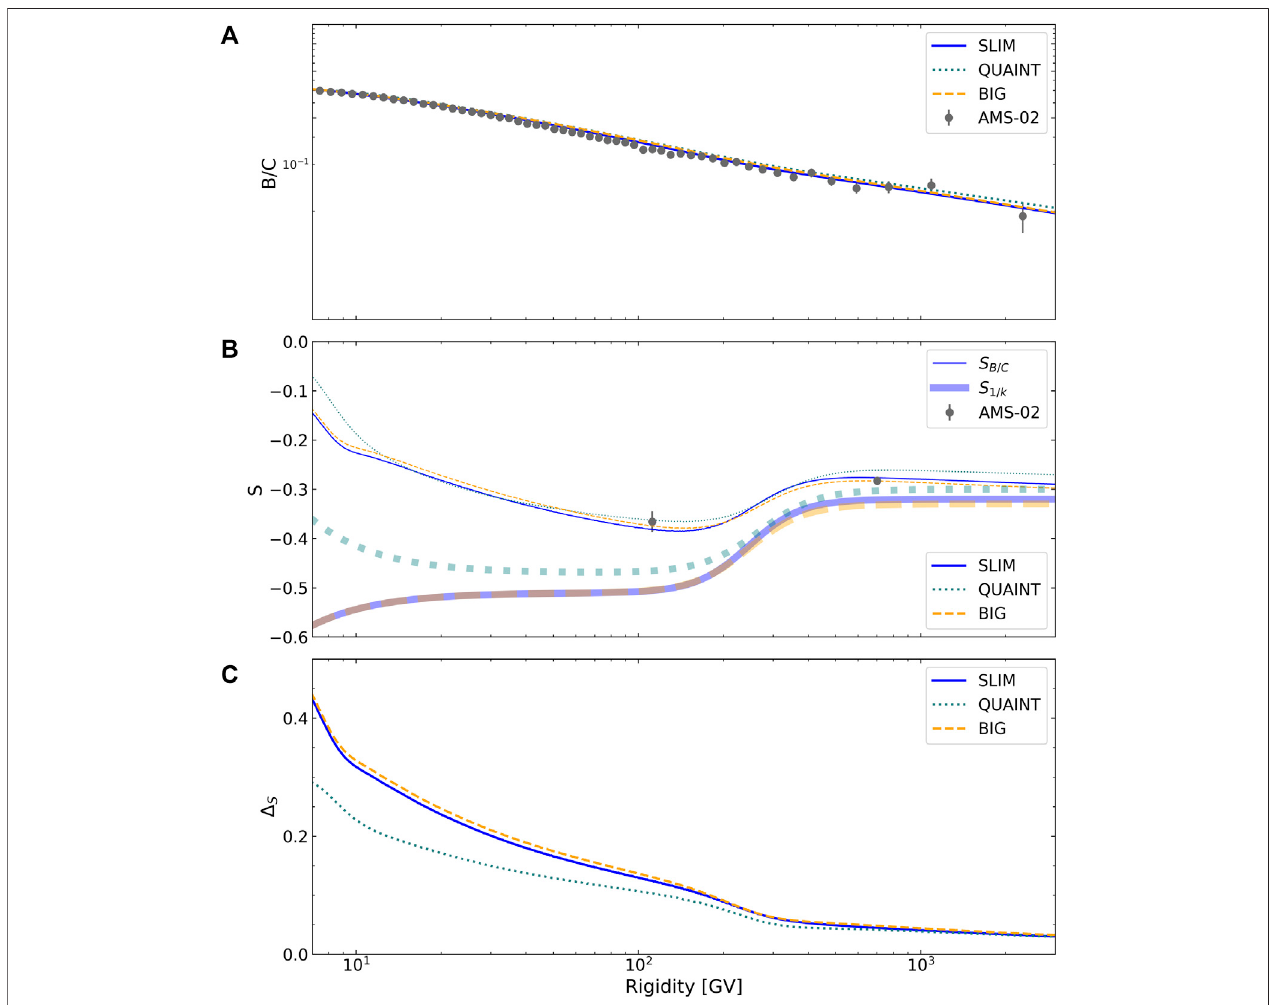
FIGURE 1 | Shown as a function of rigidity and for the three con fi gurations SLIM (blue solid lines), BIG (orange dashed lines), and QUAINT (cyan dotted lines) are (from top to bottom): (A) our B/C calculations (lines) and AMS-02 data [3]; (B) logarithmic slopes S B/C for the above B/C calculations (thin lines) and for AMS-02 data at tworigidities[3],alongwiththelogarithmicslope S 1/ K fortheinverseoftheassociateddiffusioncoef fi cient(thicklines); (C) Δ s = S B/C − S 1/ K ,thedifferencebetweentheB/Cand 1/ K ( R ) logarithmic slopes.